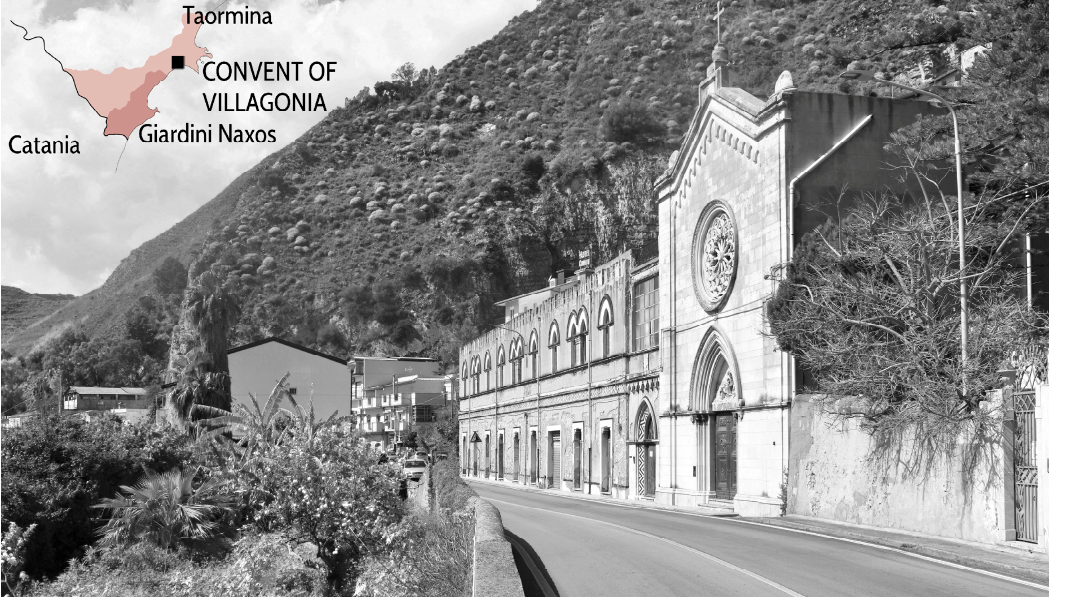
Figure 3. The façade of the Convent of Villagonia.